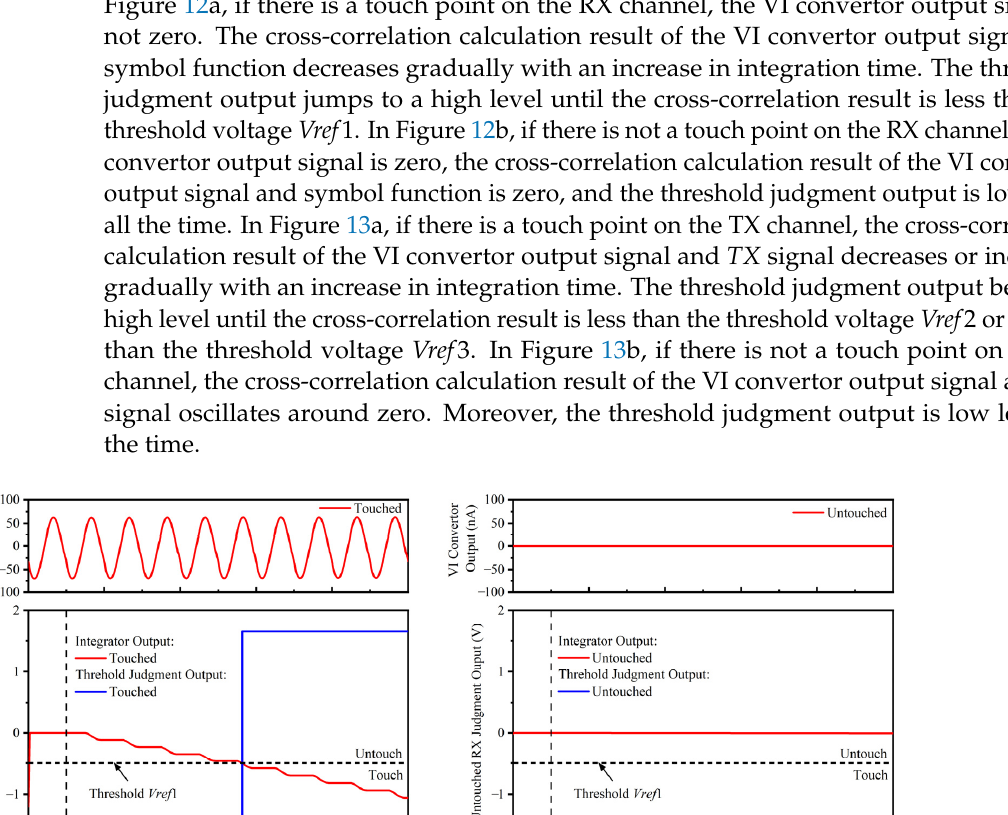
Figure 11. The cross-correlation value variation with the TX and subtractor output signal phase difference variation.